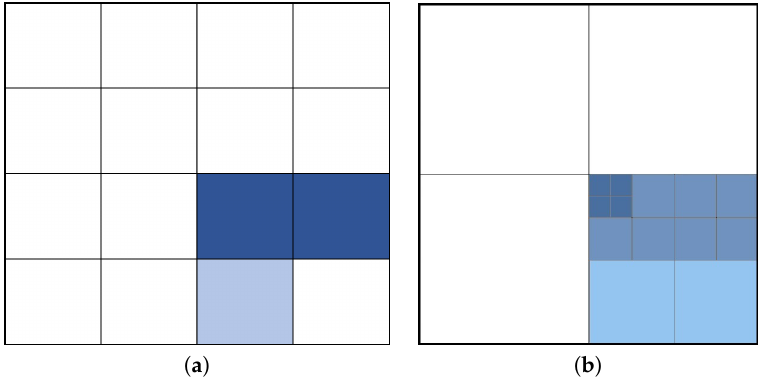
Figure 3. Area representation using ( a ) regular grid, ( b ) adaptive